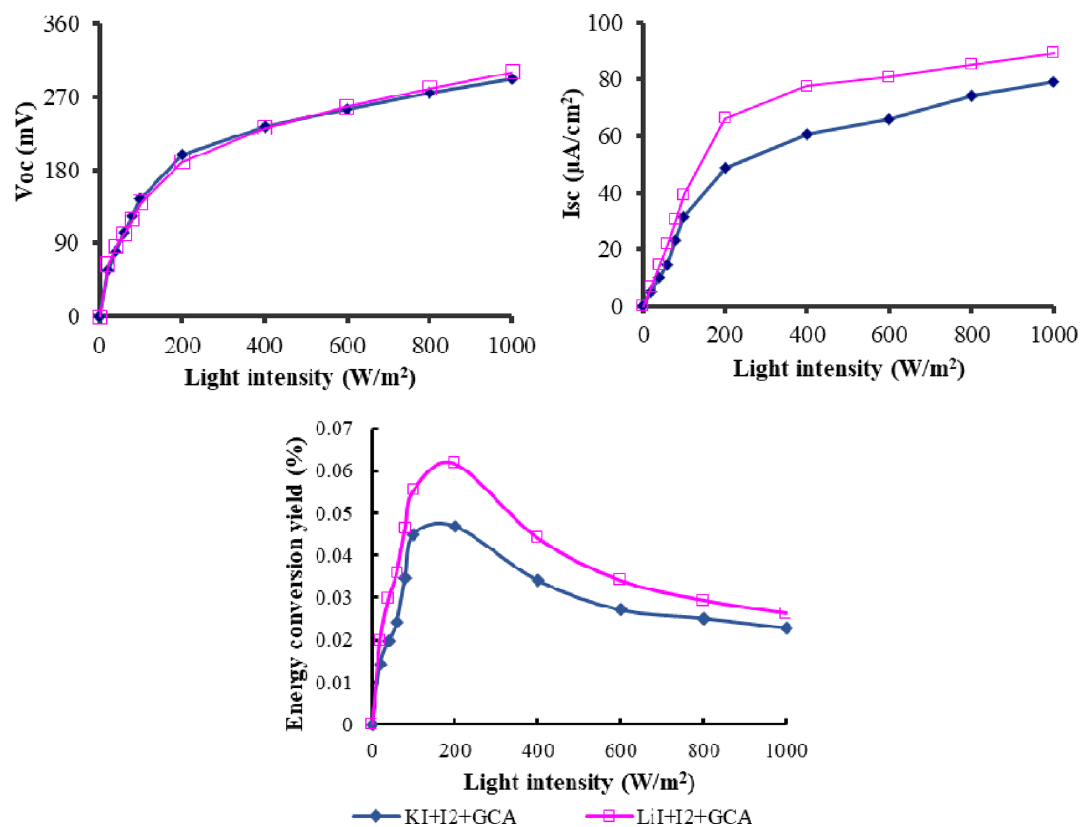
Fig. 6 Parameters affecting the performance of the DSSCs using the different redox